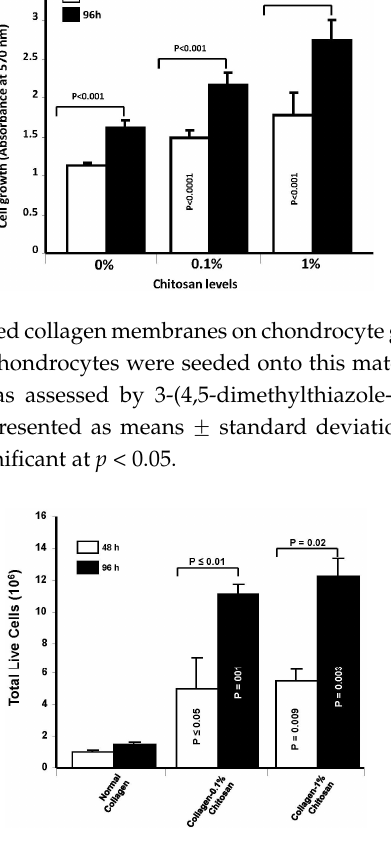
Figure 9. Level of live chondrocytes following growth on chitosan ‐ coated collagen membranes. Chondrocytes were seeded onto the membranes and culture for 48 and 96 h. At the end of each culture period, cells were detached and the live cells were determined using trypan bleu exclusion assay; n = 3.